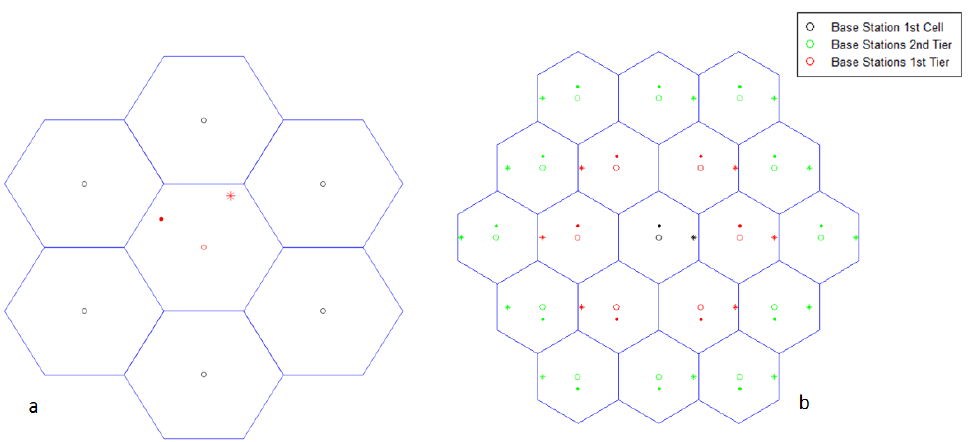
Figure 5. Considered scenarios: ( a ) 7-cell scenario; and ( b ) 19-cell